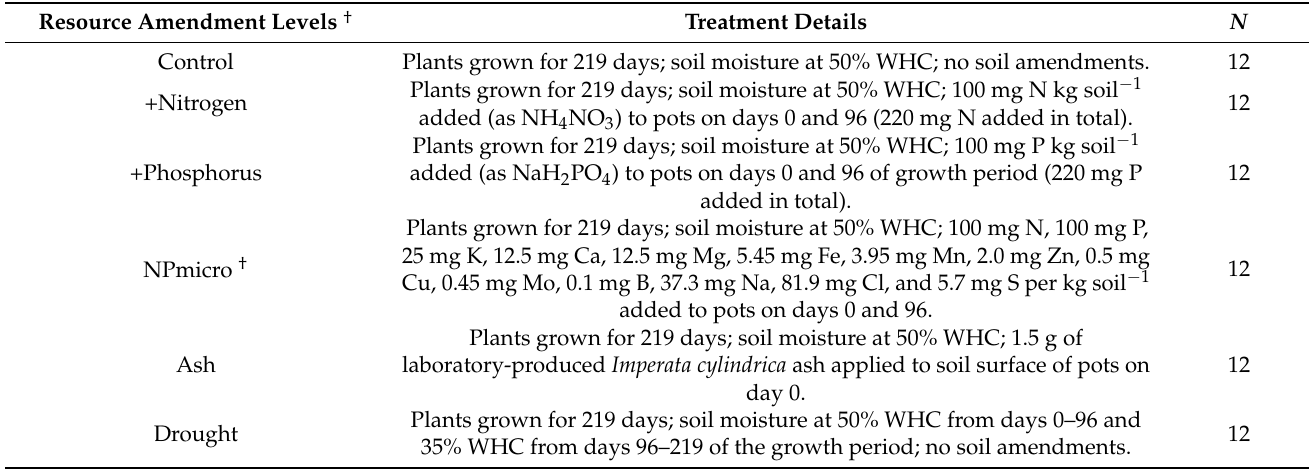
Table 2. Details of levels of the resource amendment factor in the Imperata cylindrica growth